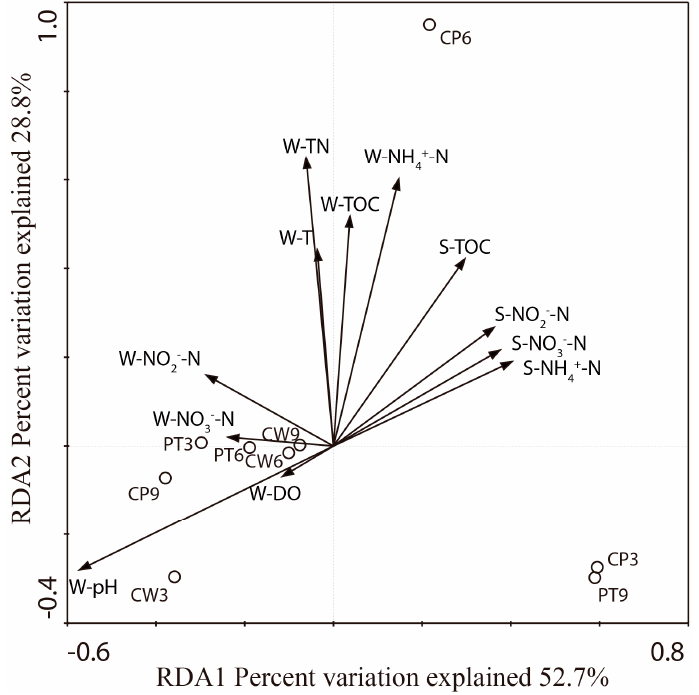
Figure 4. RDA of anammox bacteria and environment relationship.